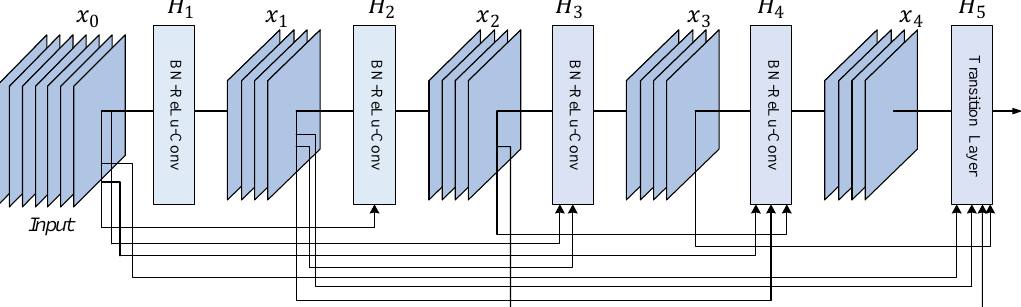
Figure 1. A five-layer dense block with a growth rate of k = 4. All preceding feature-maps are the input data of each